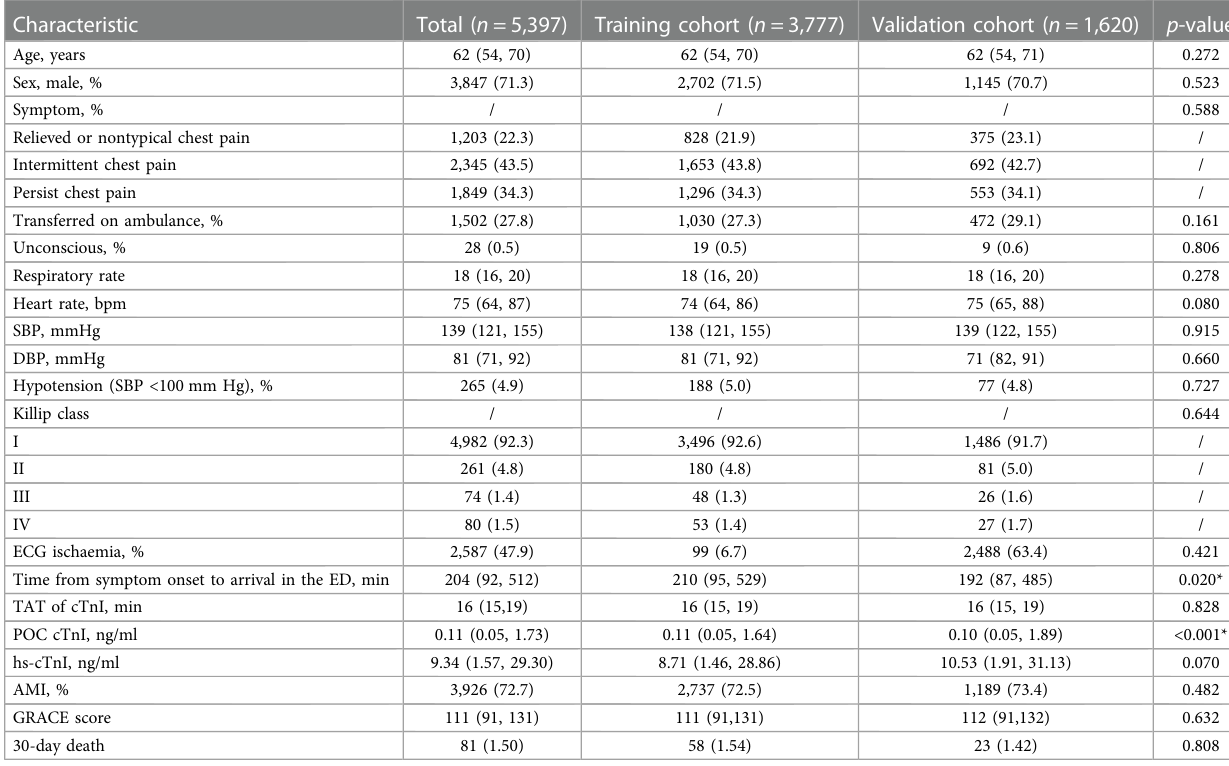
TABLE 1 Clinical characteristics of all